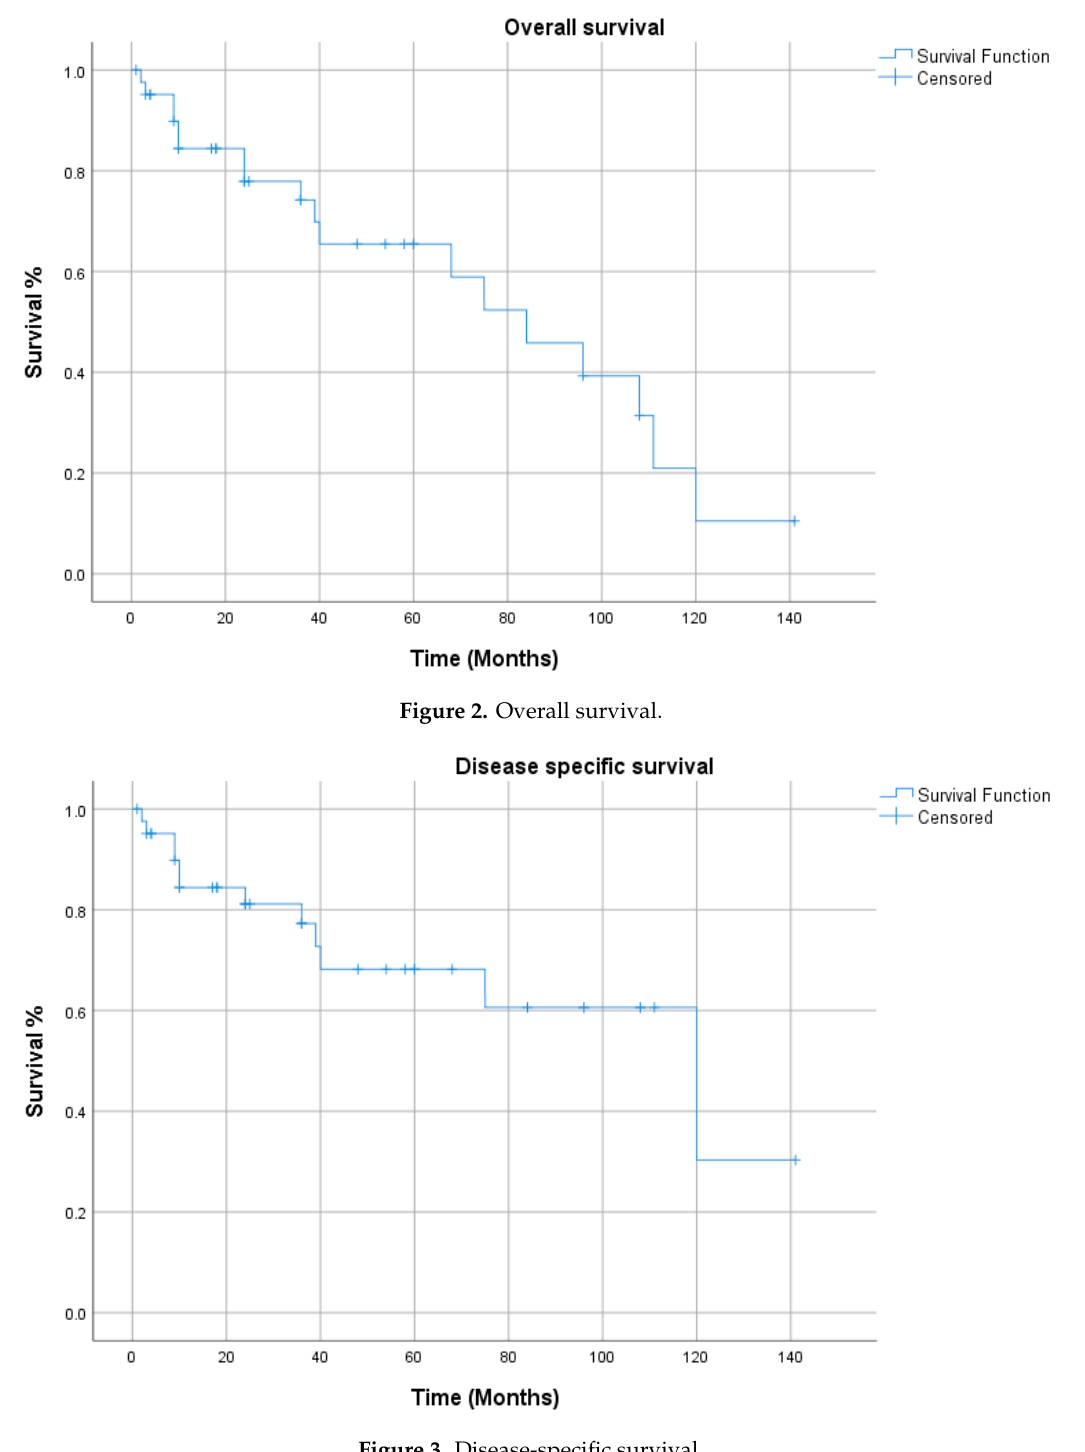
Figure 3. Disease-specific survival.